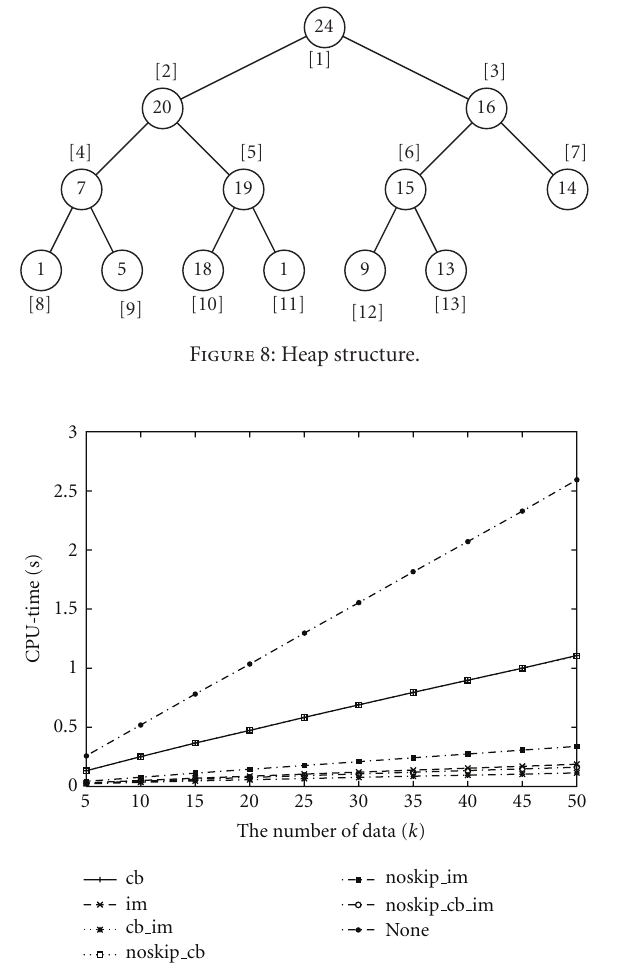
Figure 9: CPU time on 5-dimensional data.